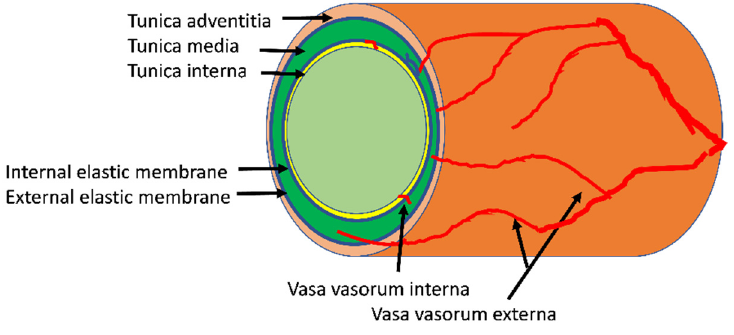
Figure 1. Most microvessels of the vasa vasorum enter the vessel wall from the adventitial layer where they tend to course longitudinally along the vessel axis. After penetrating to the media of the arterial wall they more typically orient circumferentially through the media. Much less abundant is the vasa vasorum interna with its short vessels feeding small areas of the innermost third of the vessel wall.